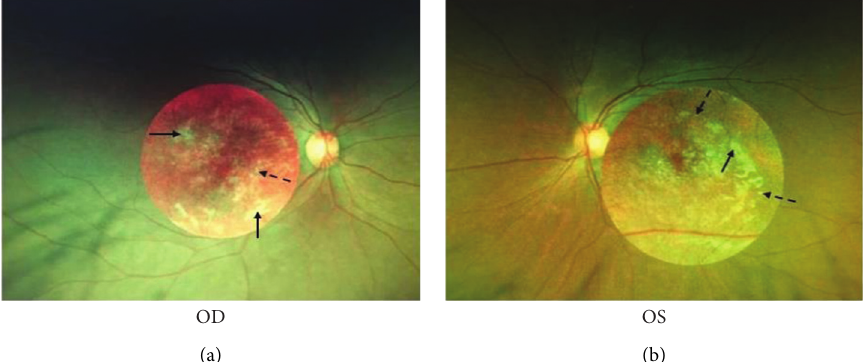
Figure 2: Fundus photographs of the proband with macular dystrophy. Fundus photographs showed macular degeneration with discrete (dashed arrow) and large confluent (solid arrow) macular drusen. OD, right eye; OS, left eye.